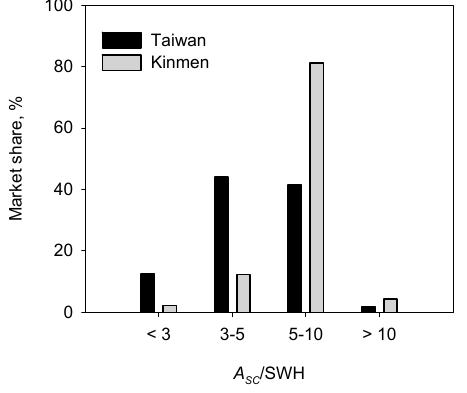
Figure 7. Market share in terms of scale of SWHs in Taiwan and Kinmen County.